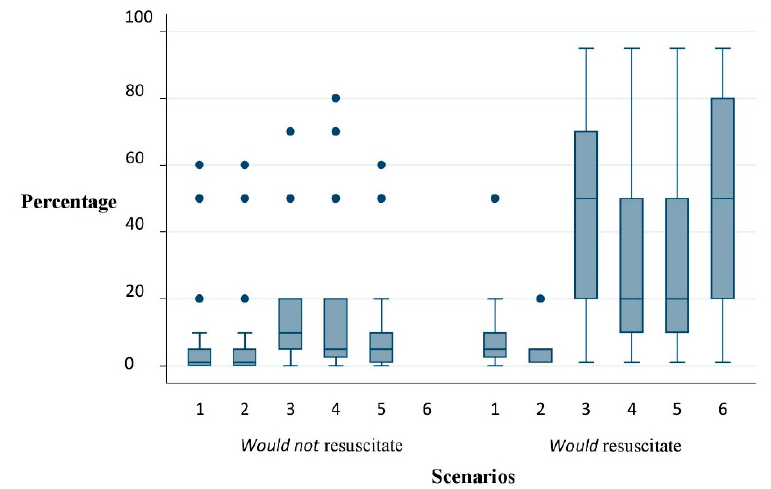
Figure 2. Boxplot showing the distribution of predicted survival by scenario and resuscitation decision.